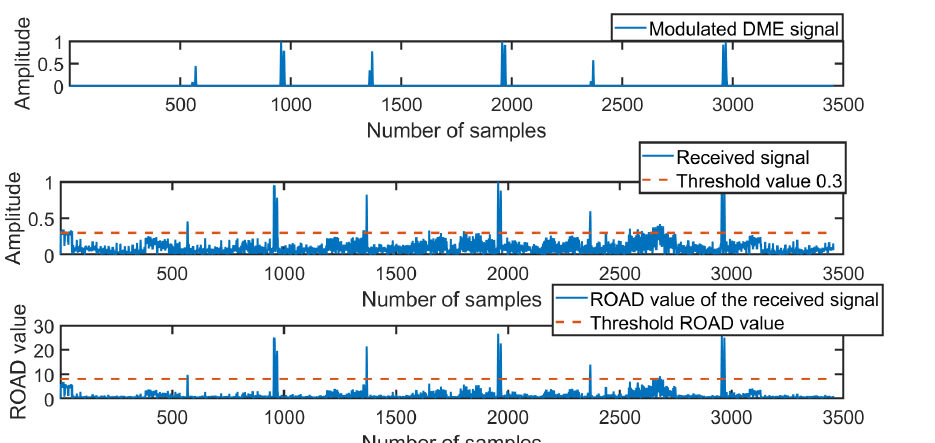
Figure 9. DME interference ( Top ), amplitude of the received signal without interference mitigation ( Middle ) and ROAD value of the received signal ( Bottom ) for an SNR of 15 dB.